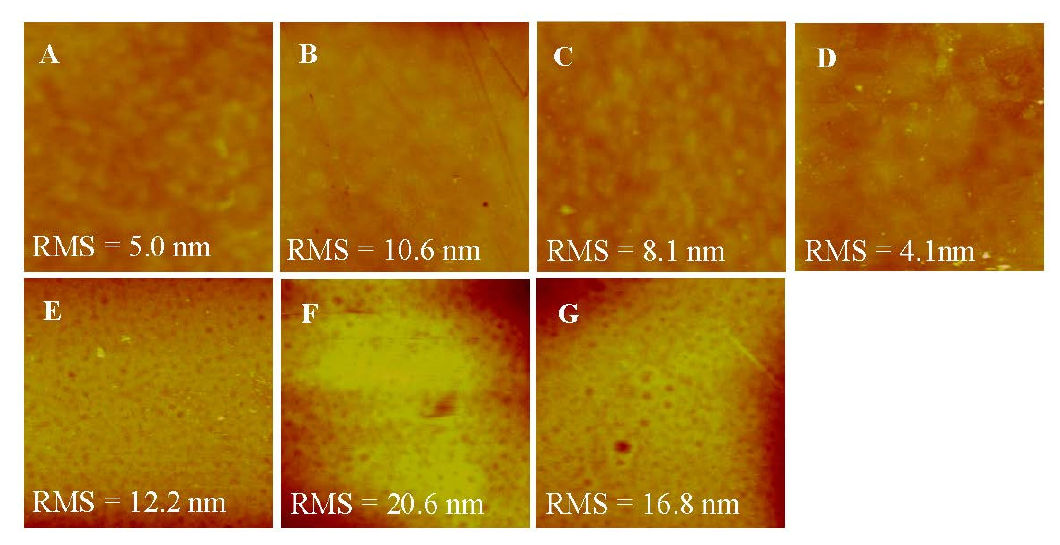
Figure 5. AFM images (scan size 2 × 2 μ m 2 ， z-scale = 100 nm) of the various membranes. ( A ) Top surface of H-PAN; ( B ) Top surface of T-PEI; ( C ) Top surface of T-PSS; ( D ) Top surface of T-AqpZ; ( E ) Bottom surface of H-PAN; ( F ) Bottom surface of T-PEI; ( G ) Bottom surface of